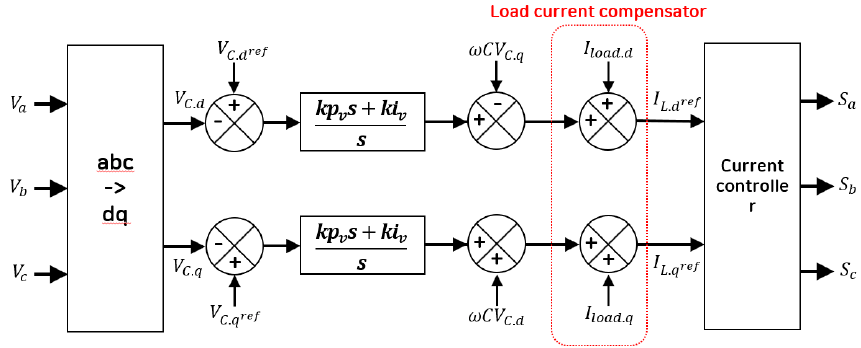
Figure 9. Proposed voltage controller compensated load current.